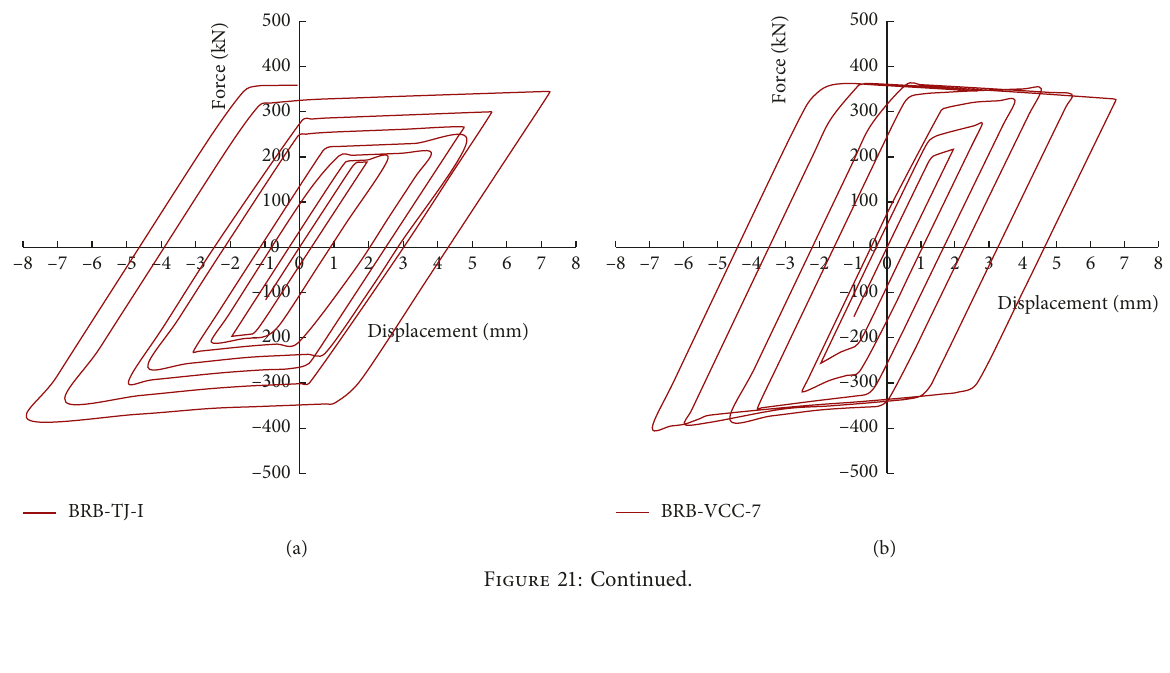
Figure 20: AC yield of the BRB-VCC-9 core. (a) Flat-plate segments yield firstly ( δ segments yield soon later ( δ y2 � 1.92 mm and F y2 � 300.9 kN). Note: AC YIELD is 1.0 in the plastic region and is 0 in the elastic